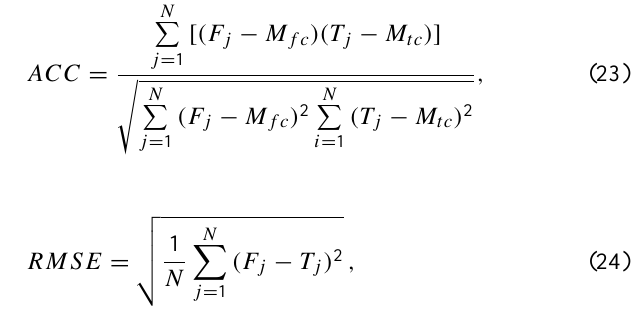
Figure 1. in ANGEO_05134